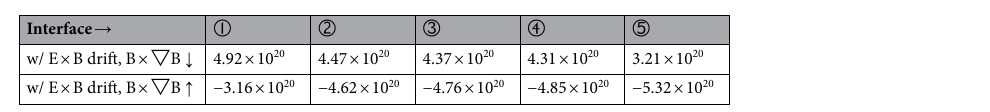
Table 2. Total particles across the interface ➀ to ➄ by E × B drift for the two cases with different toroidal magnetic field